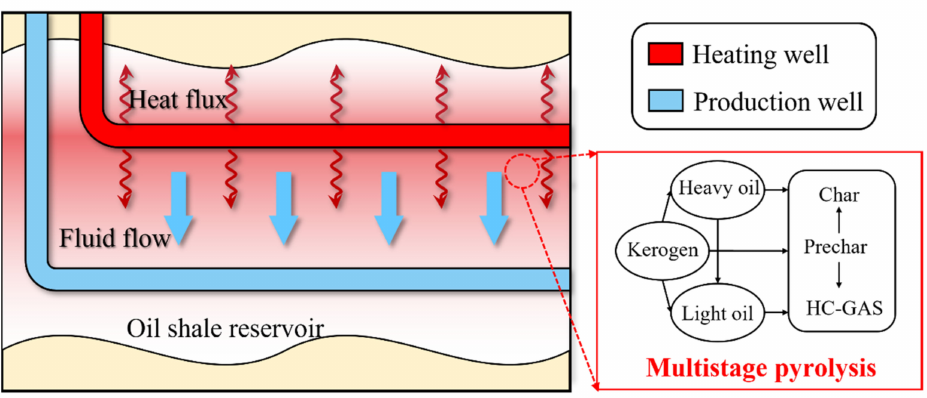
Figure 1. Schematic diagram of the in situ conversion process